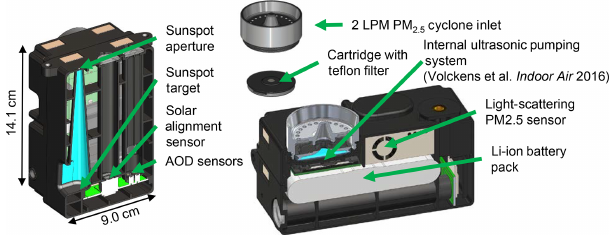
Figure 1. Computer-aided design rendering of key components of the AMOD including AOD and PM 2 . 5 measurement systems, shown as cross-sectional